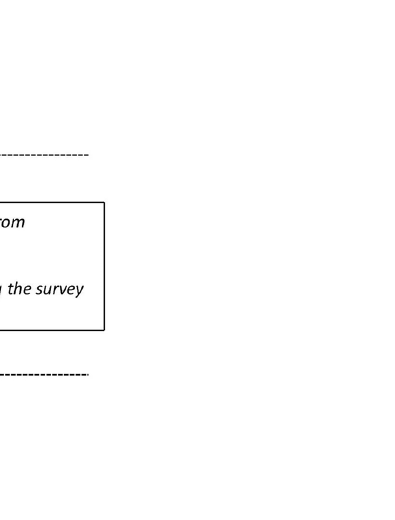
Figure 1. Recruitment process for the study